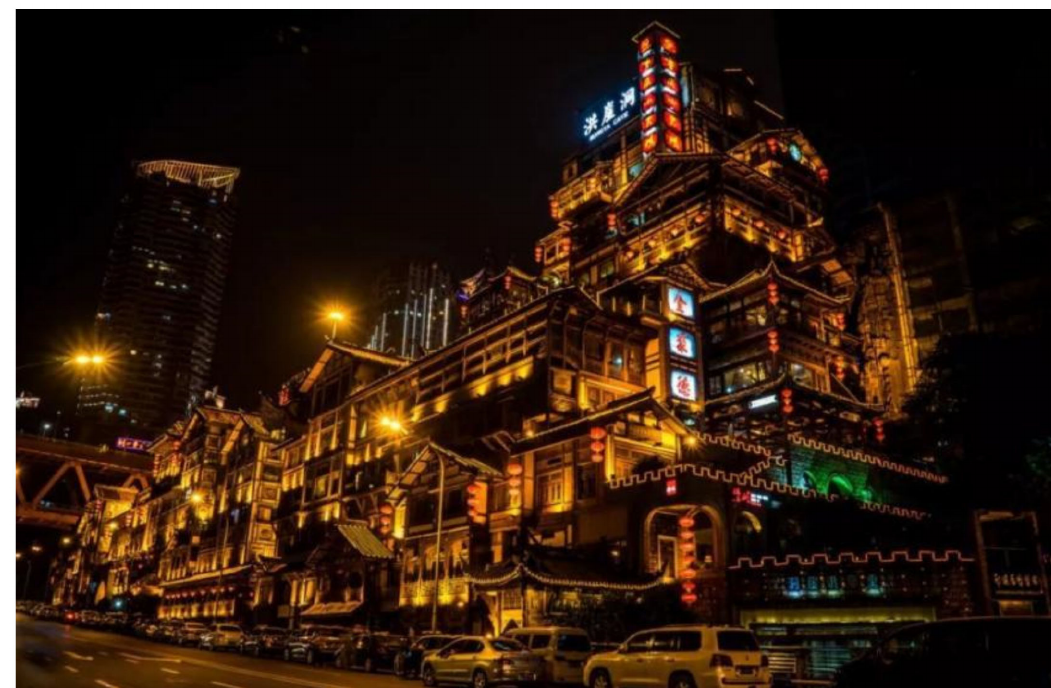
Figure 1. Textual information in multi-scale and complex scene natural